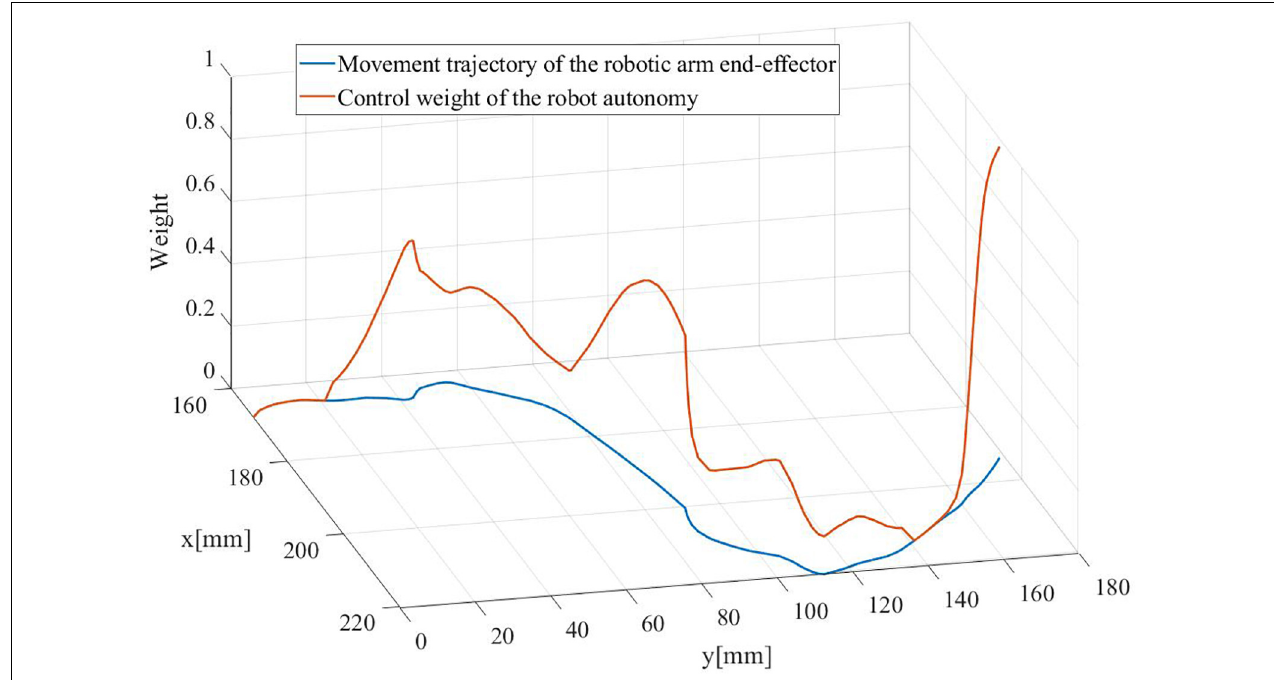
FIGURE 10 | The evolving control weight for the robot autonomy in the direction shared controller during the 9th trial executing with SC DS for subject 6.